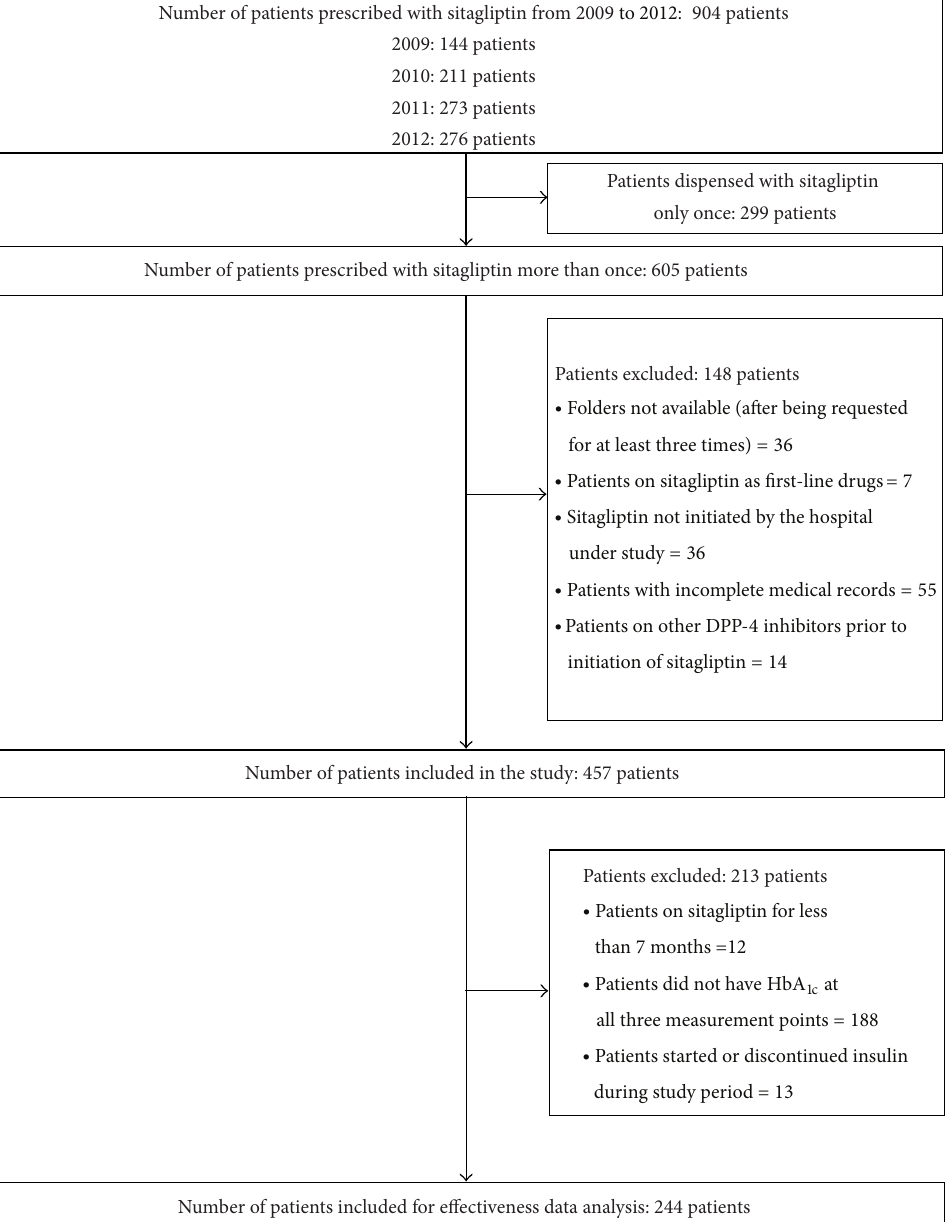
Figure 1: Inclusion of patients in the